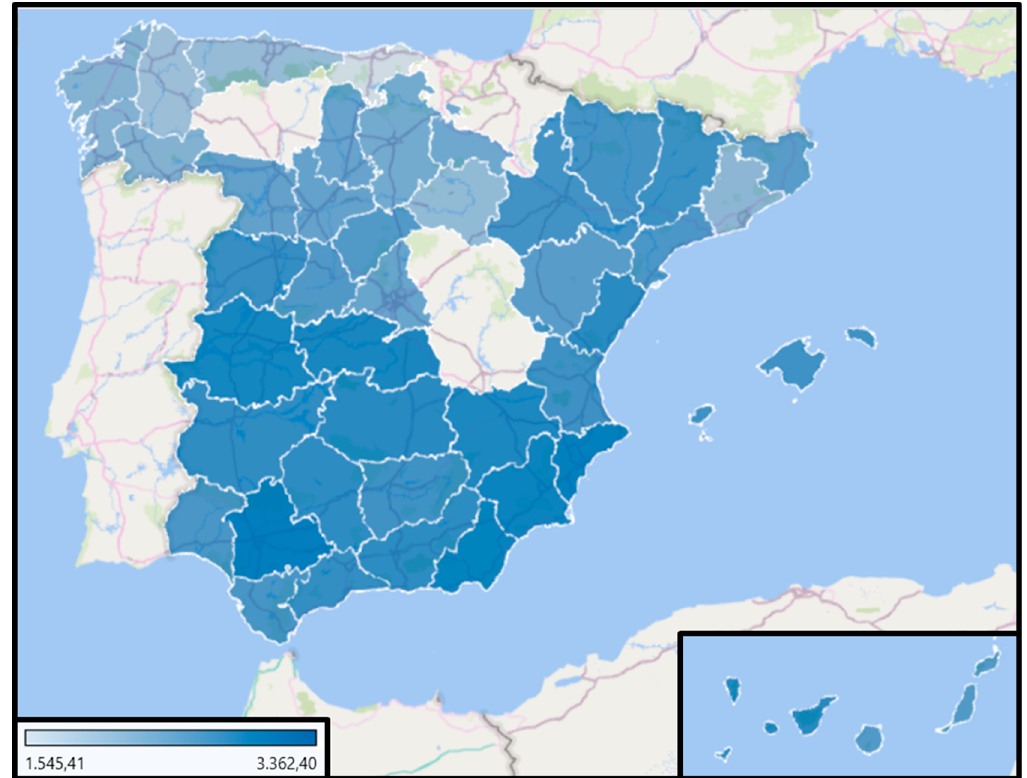
Figure 2. Average number of hours of sun per year and province (Own